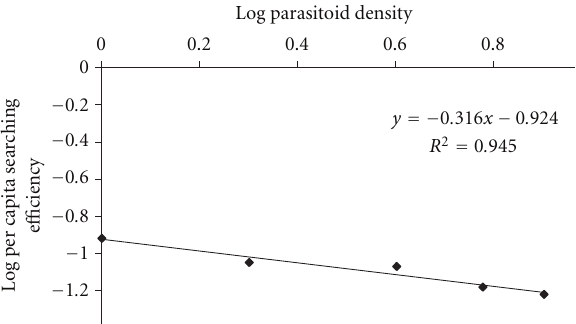
Figure 3: Regression line in mutual interference of Praon volucre on second-instar nymphs of S. avenae